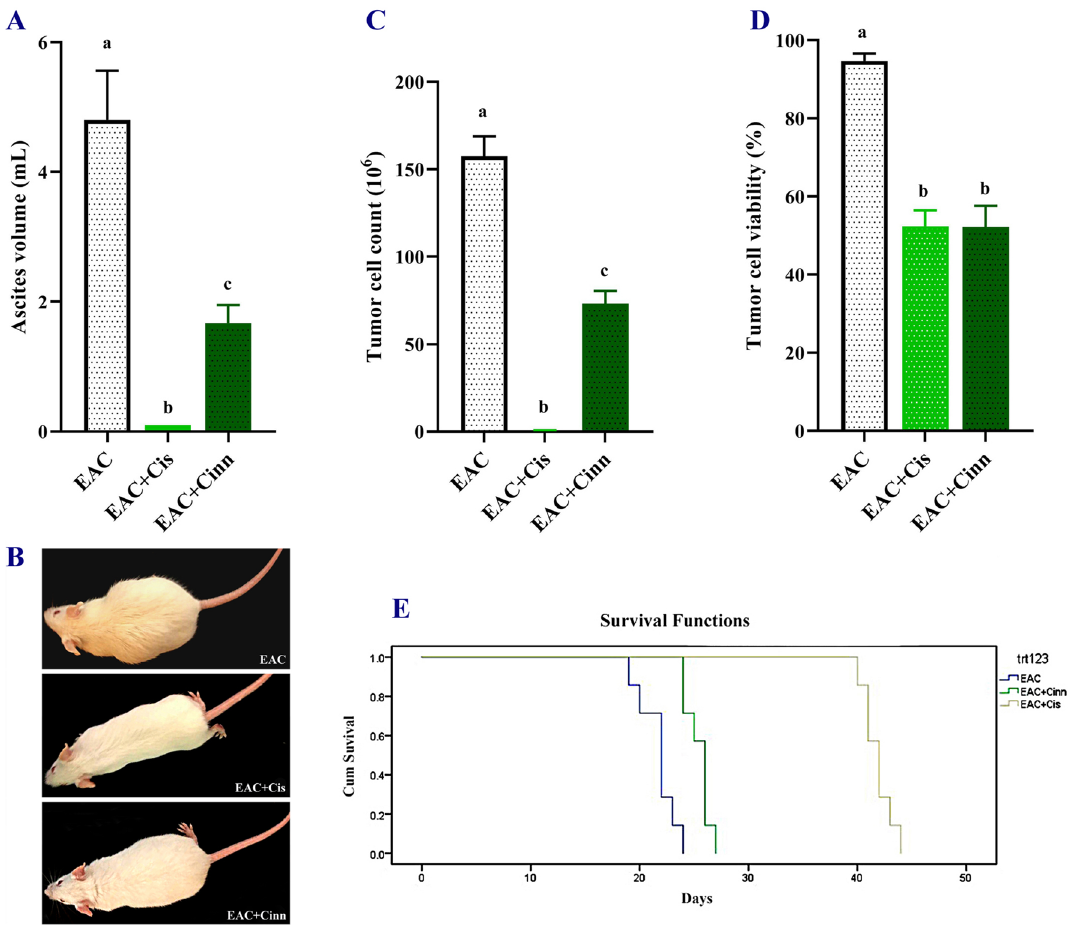
Figure 5. Effect of cinnamon essential oil (Cinn., 50 mg/kg/day, orally) on tumor burden in EAC-bearing mice. ( A ) changes in ascites volume; ( B ) changes in the macroscopic figures of EAC mice; ( C ) changes in tumor cell count; ( D ) tumor cell viability; ( E ) Kaplan–Meier survival curve. Cinn. markedly led to a decrease in ascites volume, tumor cell count and tumor cell viability beside enhancing survival of the tumorized mice. All values were presented as Mean ± SD, ( n = 3). Significant differences ( P < 0.05) between groups were shown by different letters. Cis, cisplatin (2 mg/kg b.wt, i.p).